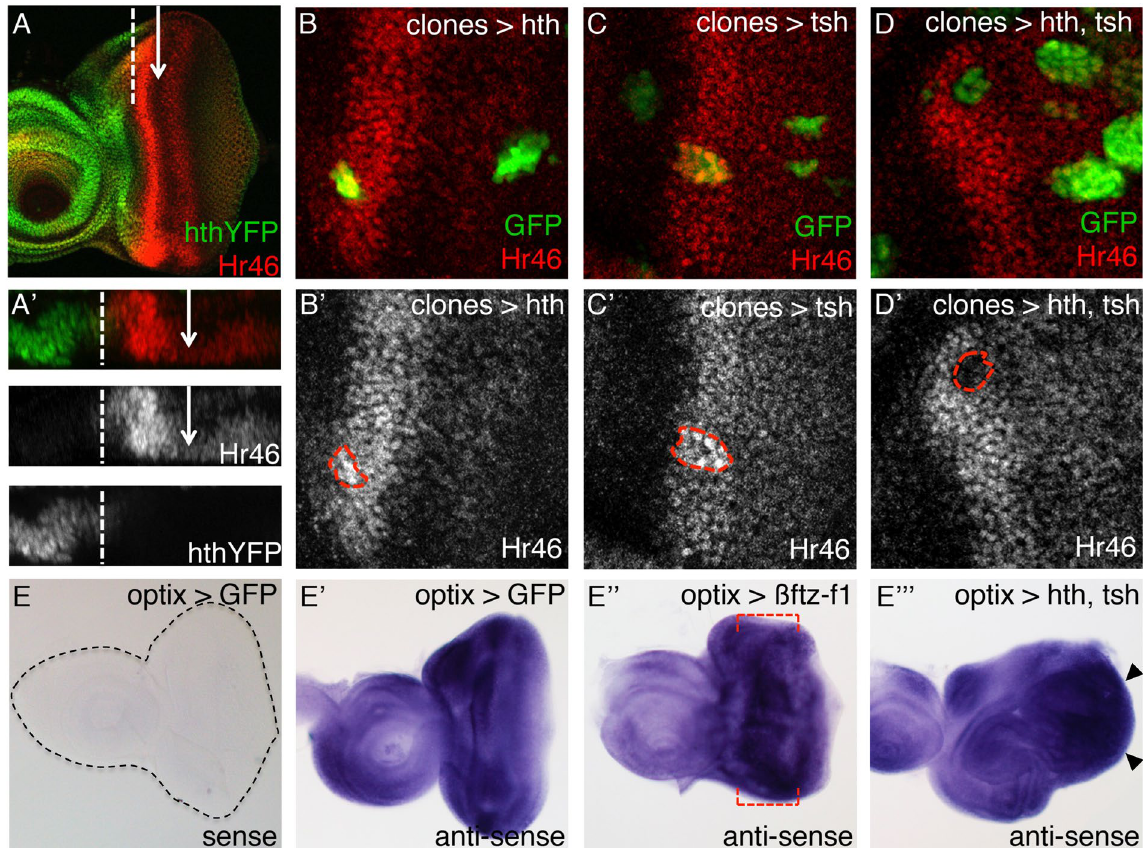
Figure 8. The expression domains of hth and Hr46 are complementary and co-expression of hth + tsh repress Hr46 . hth:YFP late L3 disc stained with anti-Hr46 ( A ) and the corresponding optical cross-section ( A’ ). The arrow marks the morphogenetic furrow (MF) and the dashed line marks the boundary between Hth and Hr46 expression. Clones overexpressing hth ( B , B’ ), tsh ( C , C’ ) or both ( D , D’ ), marked by GFP (and outlined with the red dashed line), were induced in the eye imaginal disc at 48–72 hours after egg laying. Discs are stained with anti-Hr46. ( E – E”’ ) in situ hybridization with ftz - f1 anti-sense probe in third-instar eye discs from optix > GFP ( E’ ), optix > ßfyz-f1 ( E” ) and optix > hth.tsh ( E”’ ) larvae. ftz - f1 sense probe was used as a control in optix > GFP eye discs (black dashed line outlines the disc) ( E ). ftz - f1 is transcribed in control eye discs in a dynamic pattern, with high expression in the anterior region and lower levels in the most posterior region. Red dashed lines mark the region where ftz-f1 expression is expected to be higher in optix > ßfyz-f1 discs. hth + tsh discs show higher ftz-f1 levels (black arrowheads mark the regions with especially strong ftz - f1